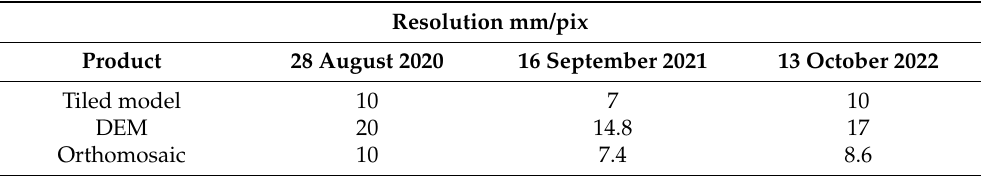
Figure 4. Agisoft 3D model based on DJI Phantom 4 UAV surveys on ( a ) 28 August 2020; ( b ) 16 September 2021; ( c ) 13 October 2022. Table 2. Agisoft products resolution (mm/pixel).